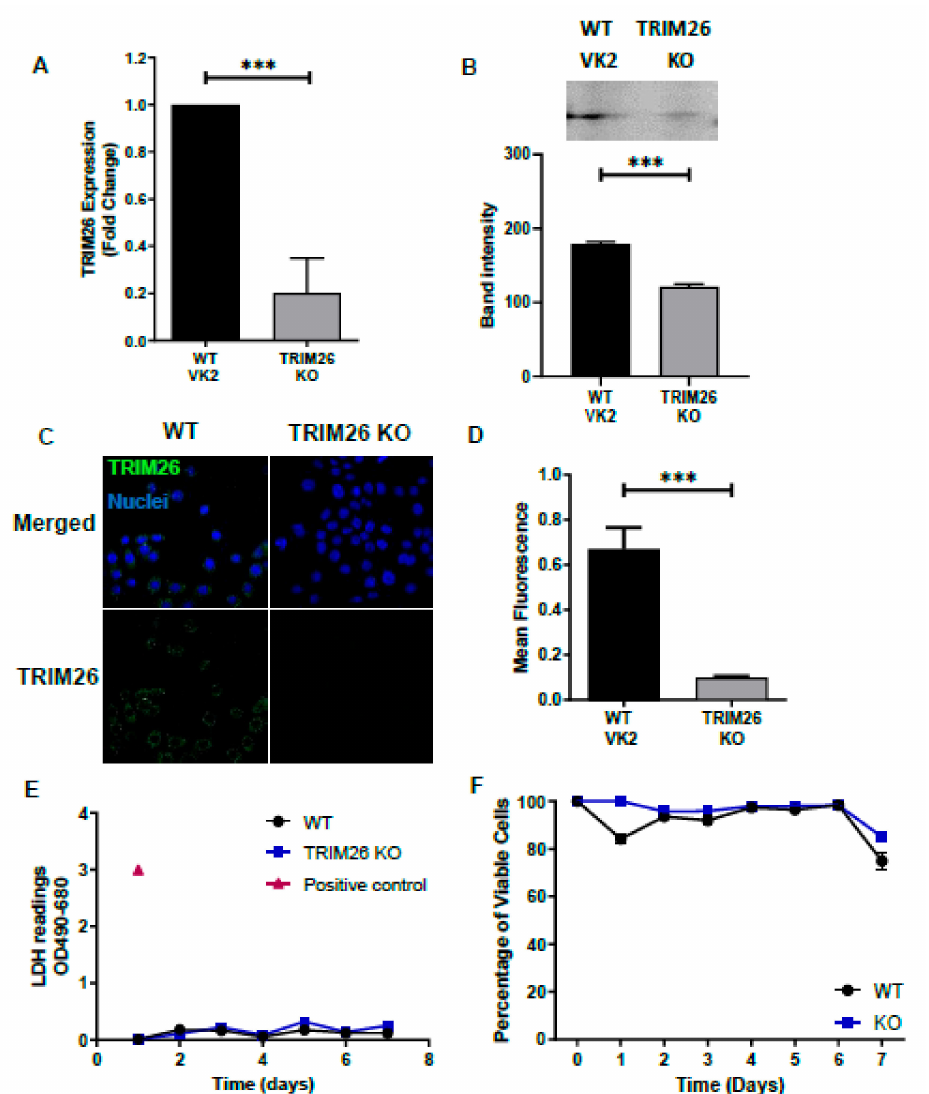
Figure 3. Validation of TRIM26 Knock out (KO) cell line. TRIM26 OE cell line was validated by comparison to WT VK2 cell line for TRIM26 mRNA and protein expression levels. ( A ) TRIM26 gene expression in WT VK2 and TRIM26 KO cell lines were analyzed by RT qPCR as fold change relative to uninfected WT controls. Results show mean ± SEM fold change ( n = 4); Statistical significance: *** p < 0.0003. ( B ) TRIM26 protein expression analyzed in WT and TRIM26 KO cell lysates by Western blot. Band intensity was measured by ImageJ software for n = 3 samples; statistical significance: *** p < 0.001. ( C ) Representative fluorescent images ( n = 5) with immunofluorescence staining of TRIM26 (green) and nuclear DNA stain (blue) for WT VK2 and TRIM26 KO by confocal microscopy. Magnification x630. ( D ) Fluorescence of TRIM26 protein from immunofluorescent images was measured by Image J software ( n = 5) and mean + SEM calculated. Statistical significance: *** p < 0.0003. Supernatant LDH cell viability test ( E ) and percent viable cells by Trypan blue dye exclusion ( F ) comparing WT VK2 with TRIM26 OE cells during 7 days of culture. Positive control total cell LDH shown in ( E ). Data are mean ± SEM for ( n = 3) replicate cultures for both ( E ) and ( F ). With the successful derivation and validation of both TRIM26 OE and KO VK2 cell lines, we performed functional studies to further elucidate the role of TRIM26 in HSV-2 infection. To see whether there is any possible effect of TRIM26 on initial uptake of HSV-2 we infected all three cell lines WT VK2, TRIM26 OE and TRIM26 KO cell lines for 2 h and 16 h after which cells were fixed and stained for intracellular HSV-2. Images